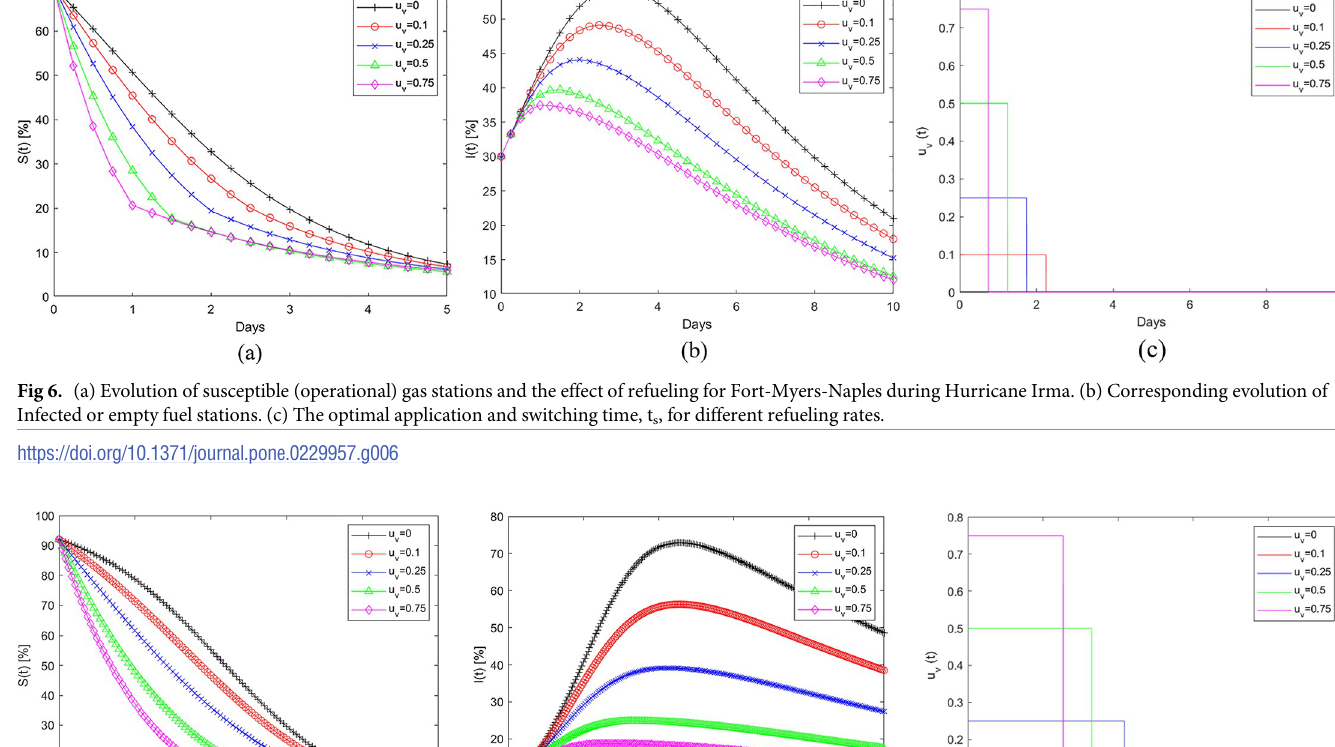
) for the major cities affected by Hurricanes Irma and Florence. v u = 0.1 u = 0.25 u = 0.50 u = 0.75 v v v v